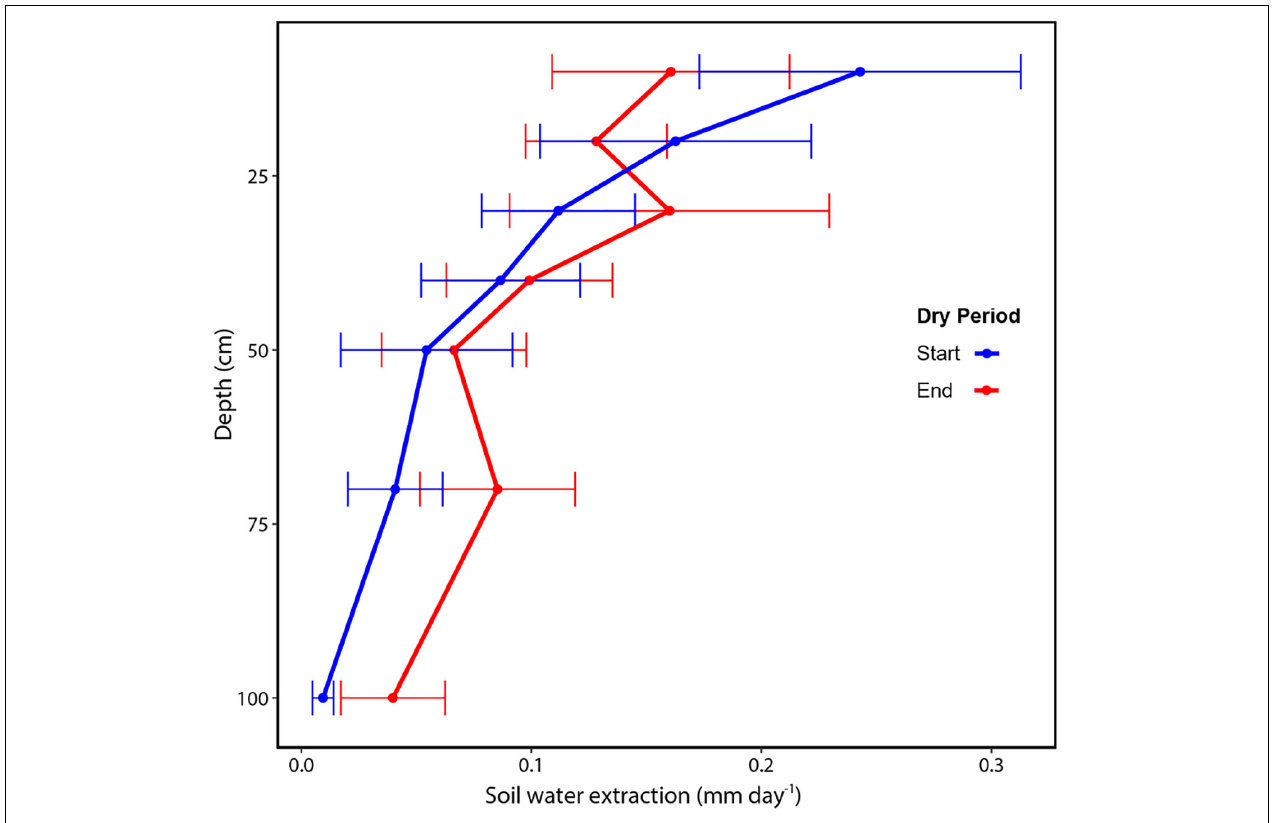
FIGURE 5 | Soil water extraction by soil layer within the top 1 m soil for a tropical wet forest in central Amazonia. The start of the dry period (blue) was September 16 and the end of the dry period (red) was October 16, 2018. Values are averaged across 5–6 sensors at each depth, ± standard